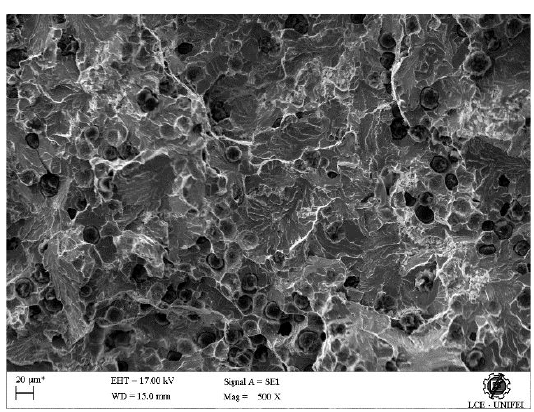
Figure 34. Fractured surface of Mo/Cu.